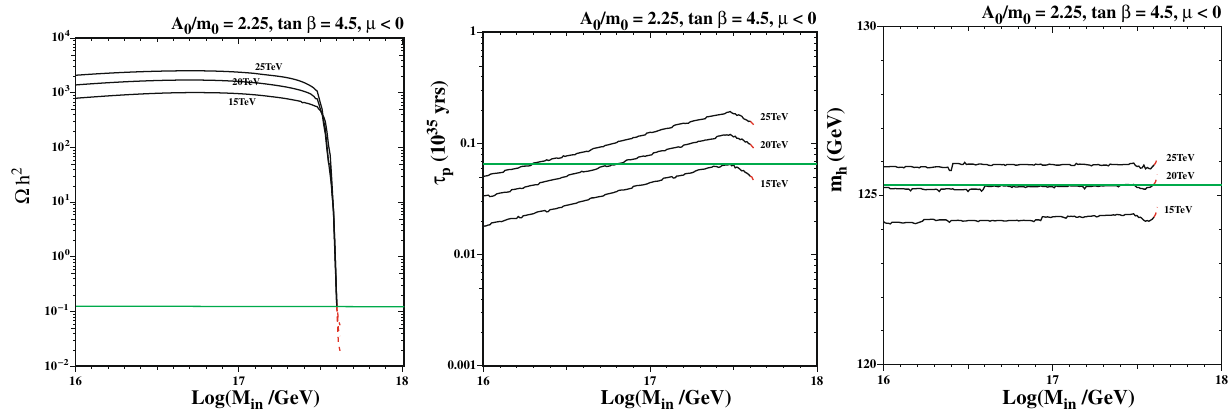
Fig. 10 As in Fig. 6, as functions of M (cid:5) for the indicated fixed values of m 1 / 2 ∈ [ 15 , 25 ] TeV and m 0 chosen to obtain the cosmological value of (cid:21) 2 for M (cid:5) = 3 × 10 17 GeV, with the same values of the other input parameters as in Fig. 3 LSP h